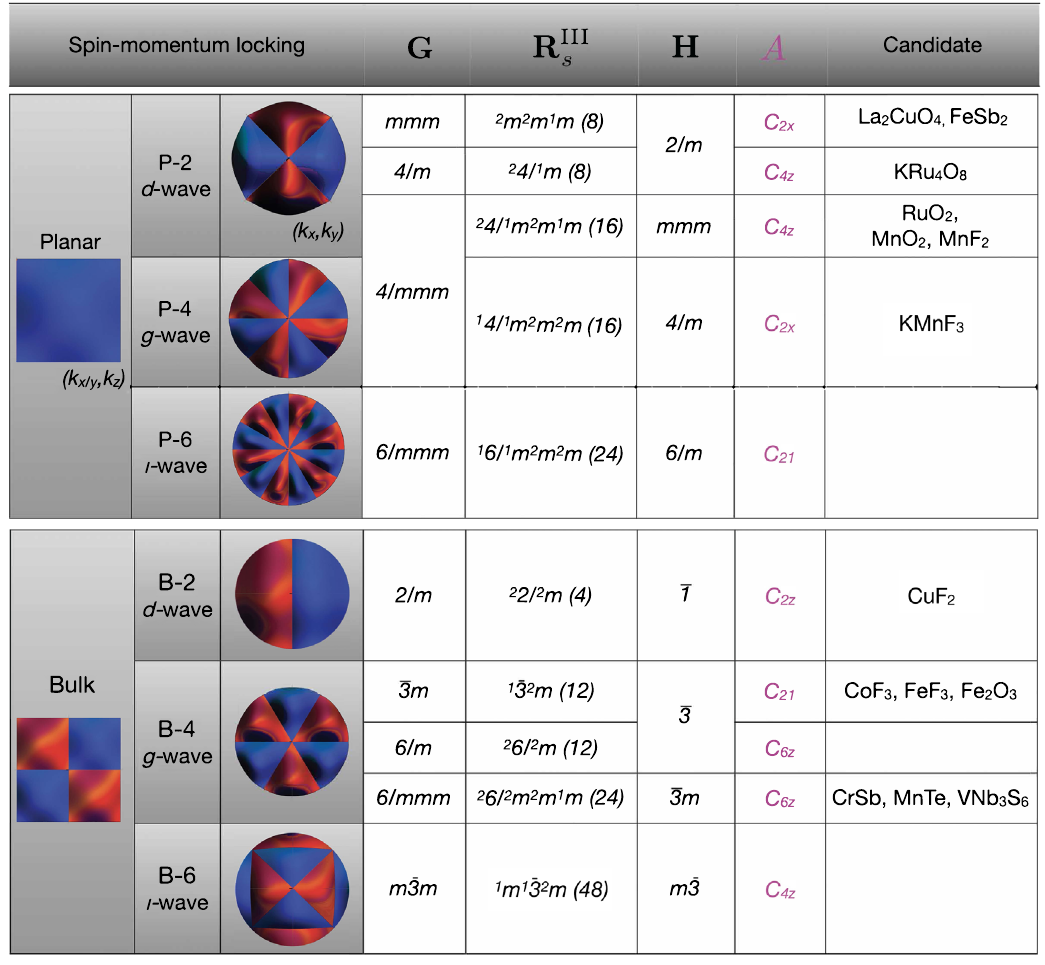
FIG. 2. Classification of spin-momentum locking in the third magnetic phase protected by spin-group symmetries, and material candidates. The columns describe the characteristic planar ( P ) or bulk ( B ) spin-momentum locking on model Hamiltonian bands with the characteristic spin-group integer and the even-parity wave form of altermagnetism, the crystallographic Laue group G , the halving subgroup H of symmetry elements which interchange atoms between same-spin sublattices, a generator A of symmetry elements which interchange atoms between opposite-spin sublattices, the nontrivial spin Laue group R III (in brackets we list the number of symmetry s elements), and material candidates of the third magnetic phase. The model Hamiltonian bands on which we illustrate the spin- momentum locking character are described in Supplemental Material Sec. III [30]. References describing the materials are in the main text and Supplemental Material Secs. V – VI